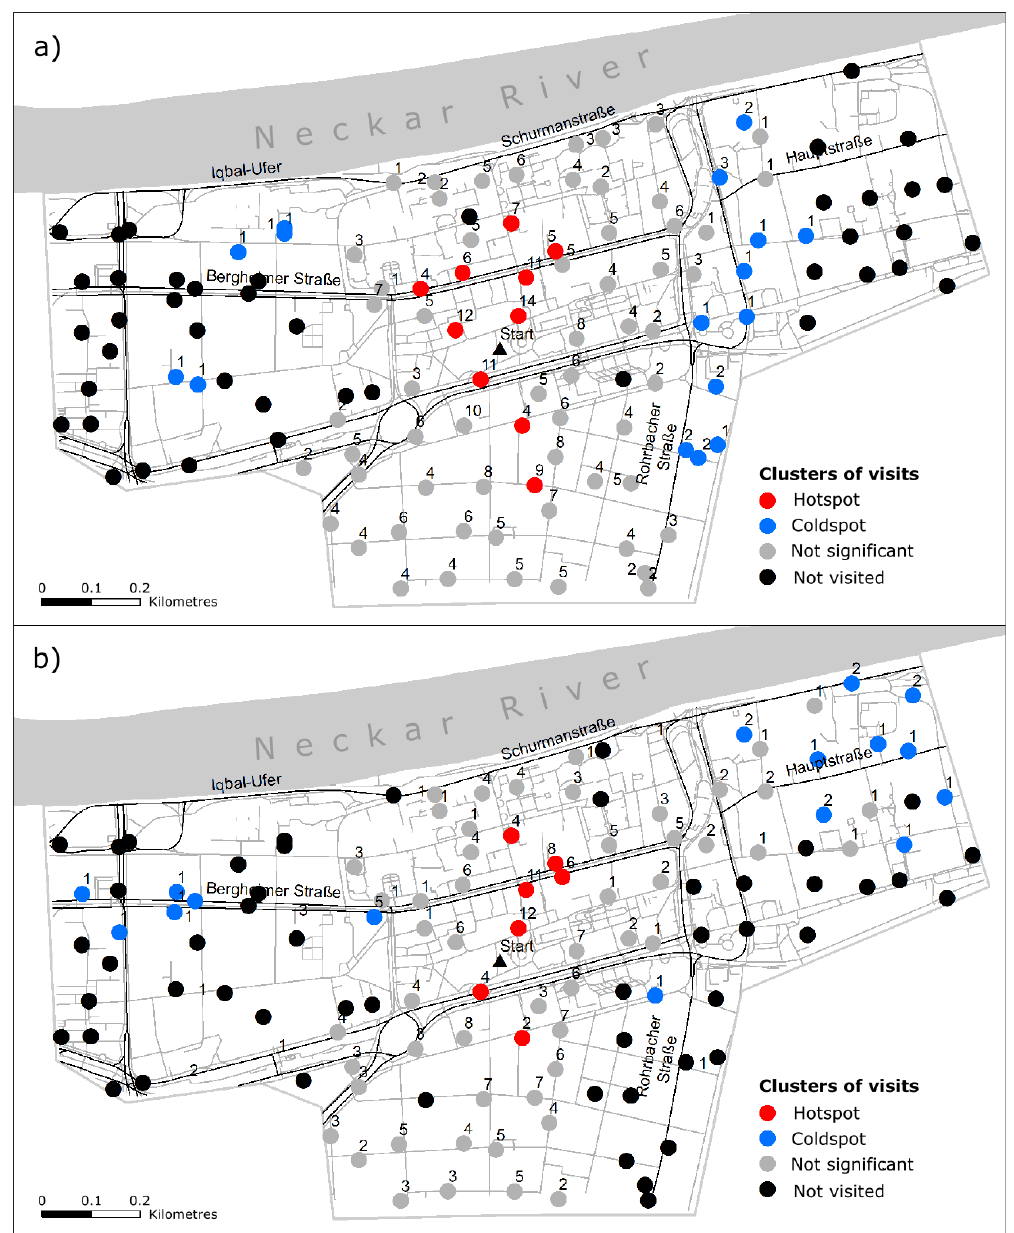
Figure 5. High and low-value spatial clusters of task visits. ( a ) Spatially structured setup; ( b ) and spatially random